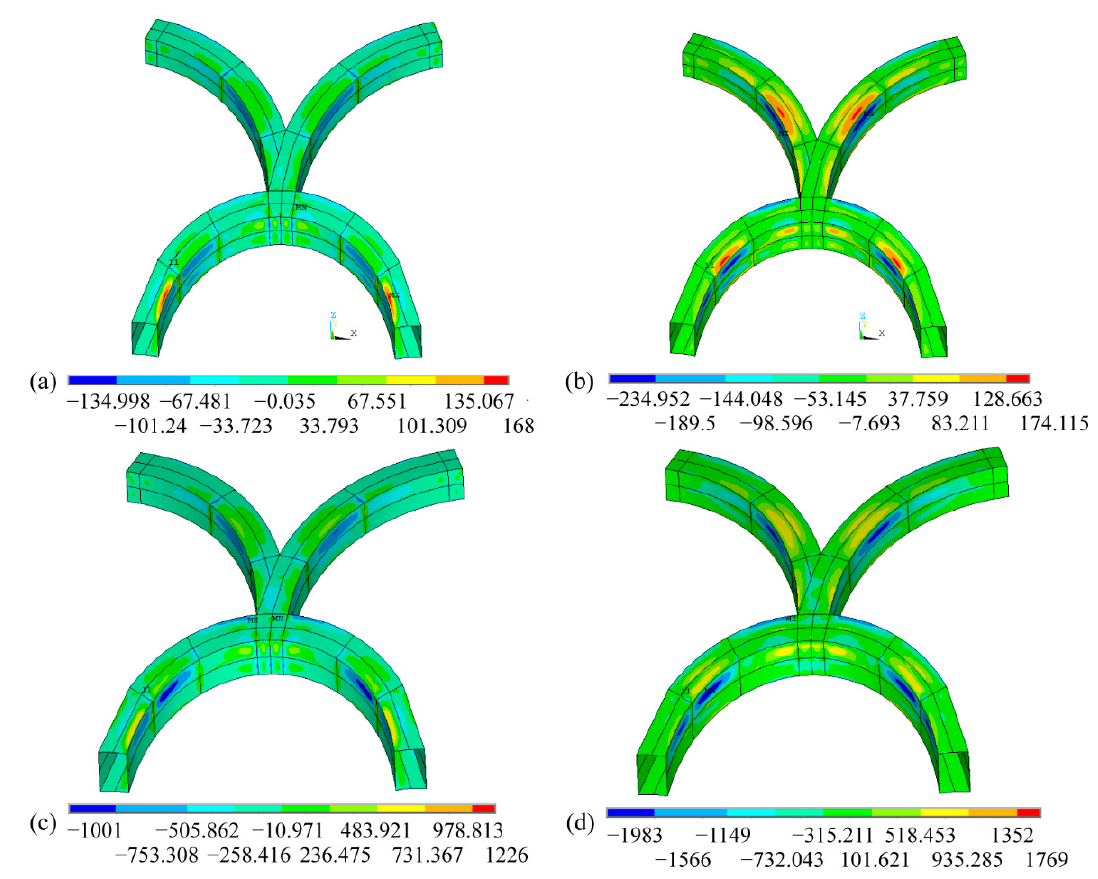
T ls = 4 Figure 13. ( a ) M11 and ( b ) M22 under 1 P and ( c ) M11 and ( d ) M22 under ultimate capacity when T ls = 4 mm.